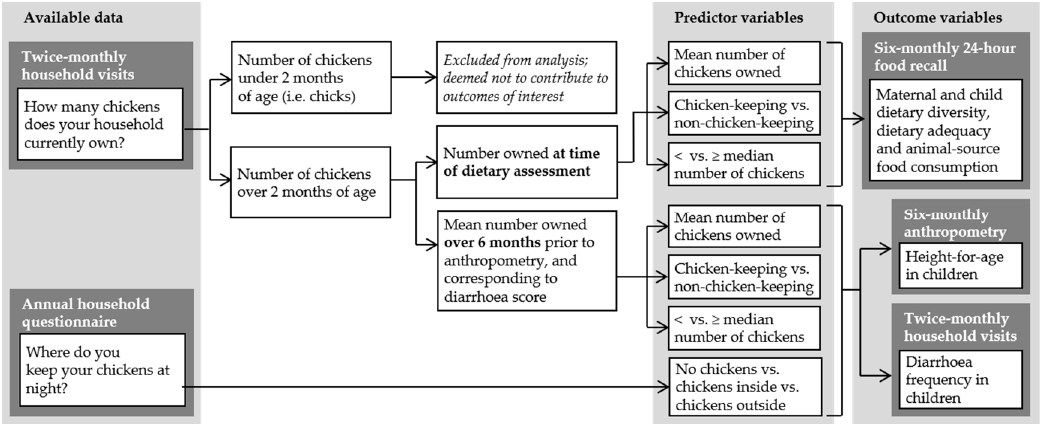
Figure 1. Construction of predictor variables to test associations between chicken-keeping and maternal and child diets, child anthropometry and diarrhea frequency (alongside other livestock and non-livestock variables). Small chicks have been excluded from chicken flock size, and consideration given to the time period over which ownership is measured.